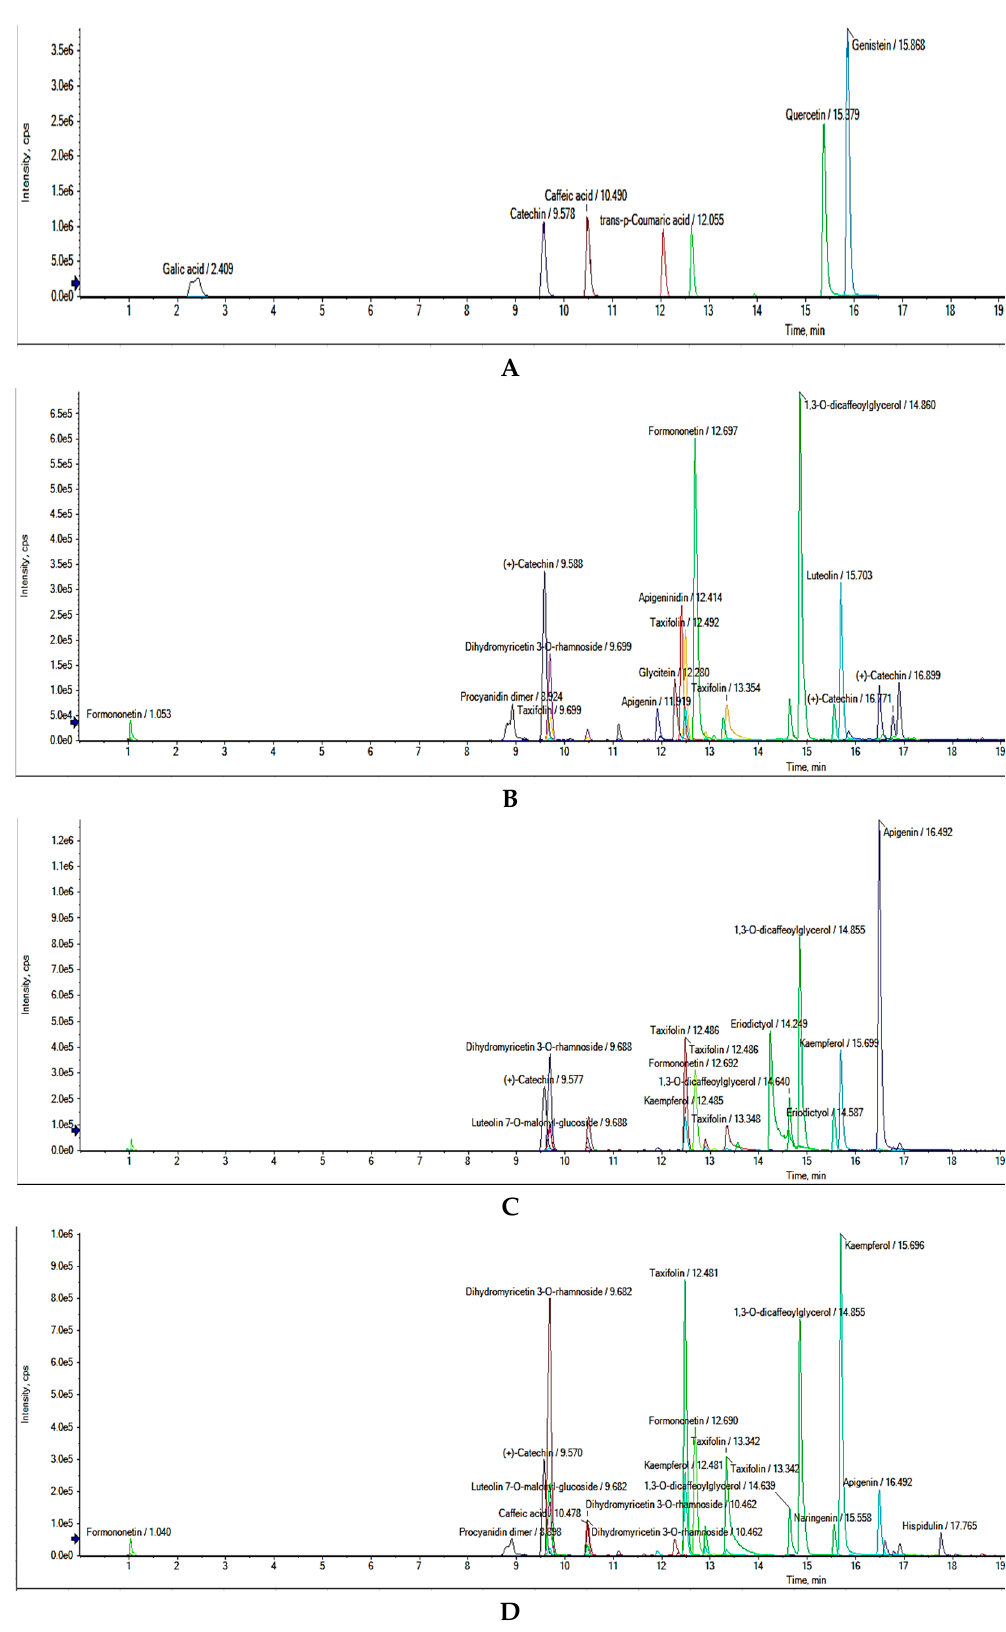
Figure 3. Decorticated sorghum grain phenolic compounds chromatographs. ( A ) Authentic standard compounds; ( B ) DSOR 11; ( C ) DSOR 17 and ( D ) DSOR 33. Detection was achieved at 280 nm. Table 2. Phenolic compounds identified in the ethanol extracts of DSOR 11 by UHPLC-Q-TOF-MS 2 . RT: Retention time.